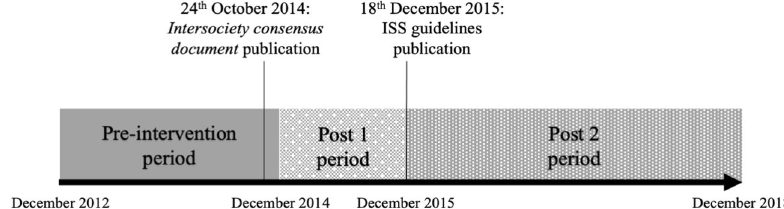
Fig. 3 Study design (Pedianet, 2012 – 2018). The arrow represents the timeline where are indicated the date of the publication of the two guidelines and the study periods with the corresponding starting and ending date colored with different textures of gray. ISS Istituto Superiore di Sanita ’ - Italian Institute of